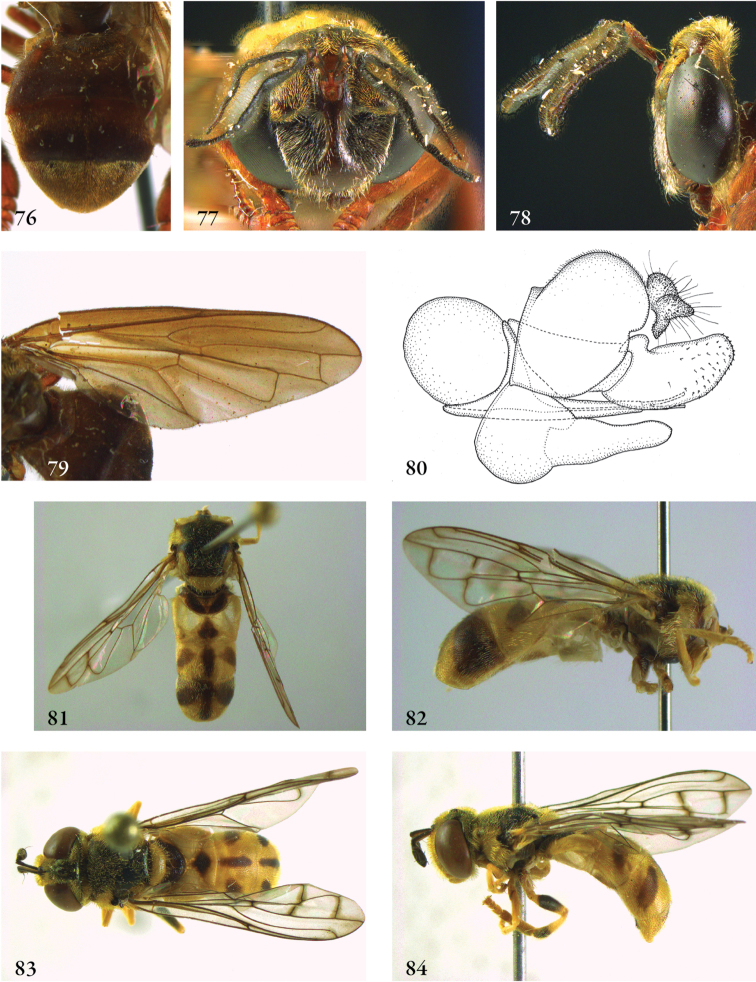
76–80
Furcantenna nepalensis male (holotype): 76 abdomen dorsal 77 head frontal 78 head lateral 79 wing 80 genitalia lateral 81–82
Heliodon doris male (holotype): 81 habitus dorsal 82 habitus lateral 83–84
Heliodon doris female (paratype): 83 habitus dorsal 84 habitus lateral.